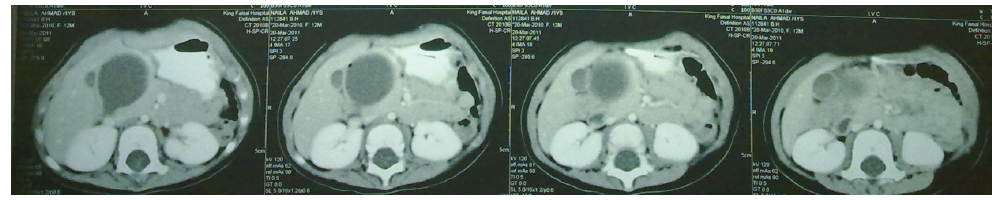
Figure 3 : CT scan of the abdomen with an IV and oral contrast showing evidence of cystic structure in the first and proximal second part of the